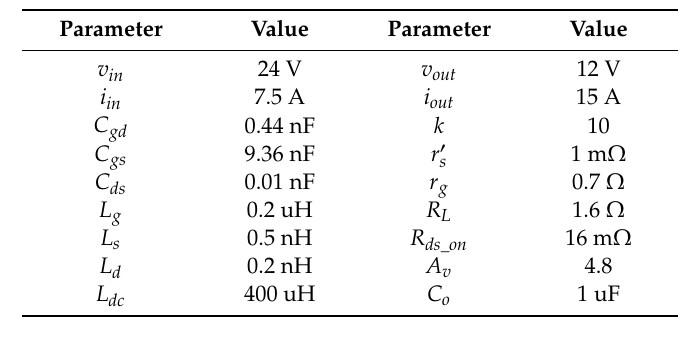
Table 1. The parameters of the dc-dc converter system.